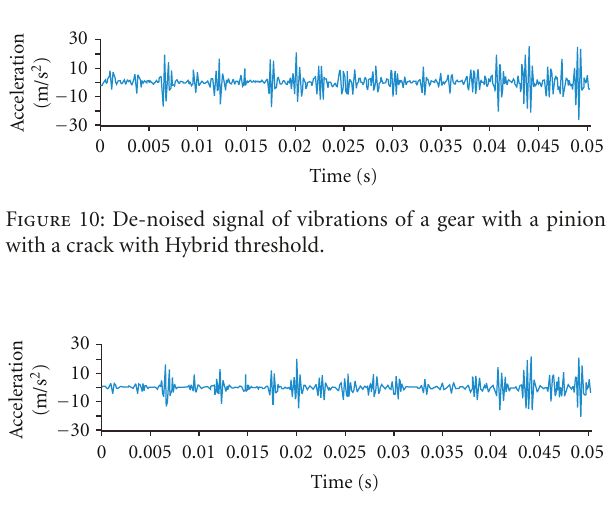
Figure 11: De-noised signal of vibrations of a gear with a pinion with a crack with Minimax threshold.